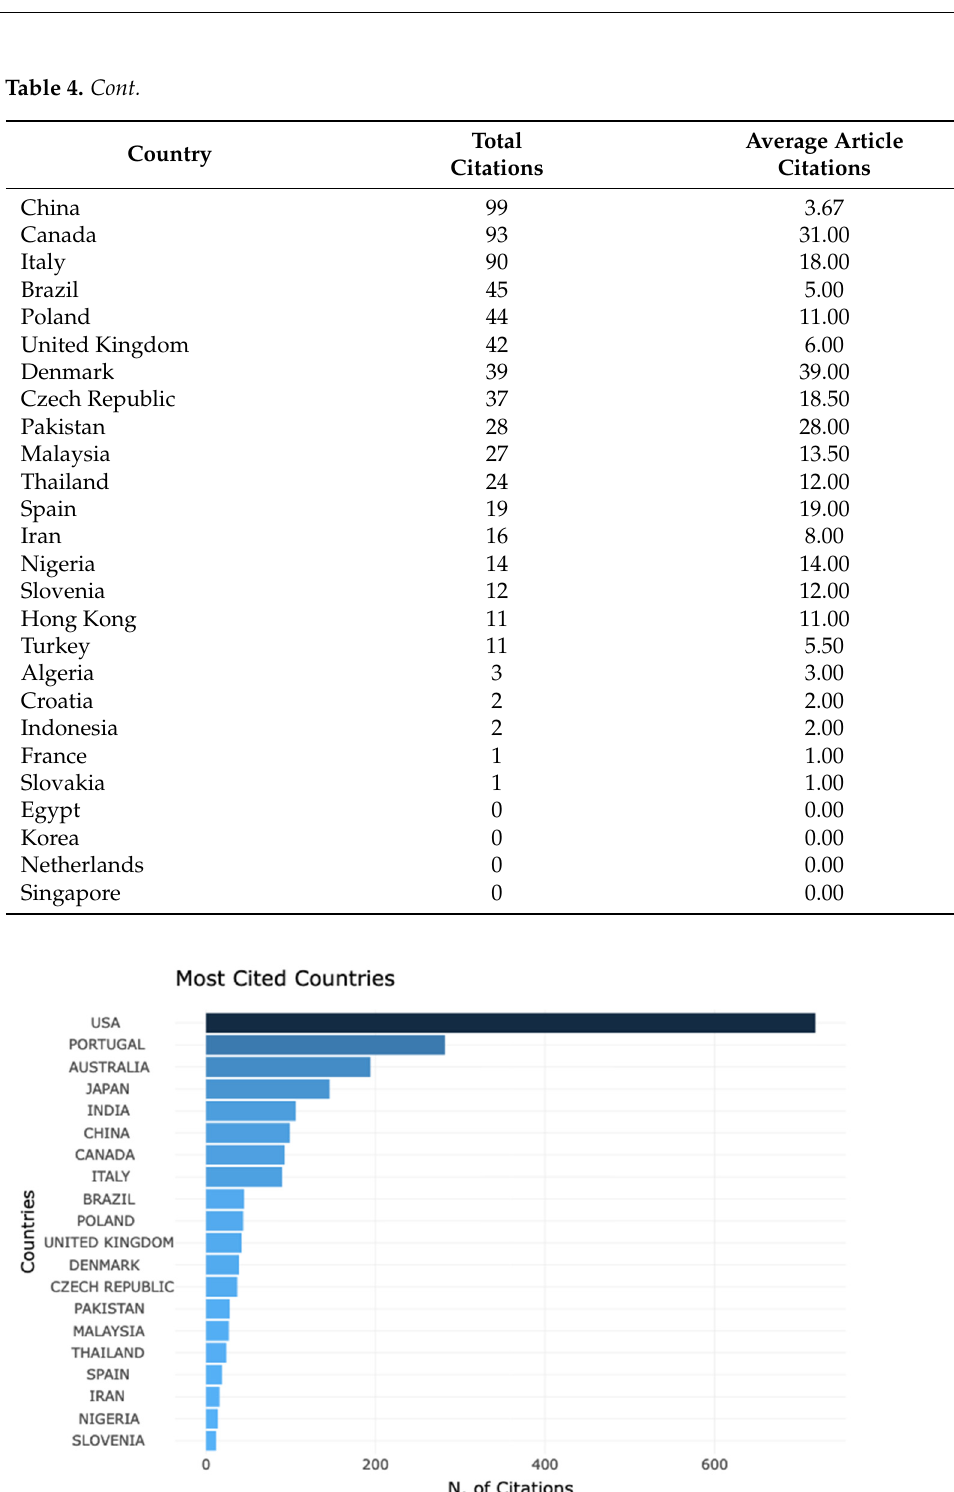
Table 3. Countries’ scientific production on geosyinthetics research entrenched with managerial implications, as considered in this study.